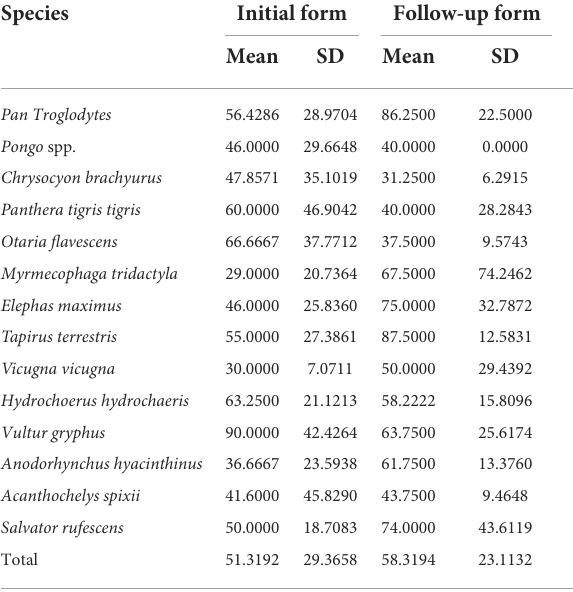
TABLE 4 Time in minutes (mean + /– SD) required to complete initial and follow-up welfare assessment forms of Ackonc-AWA